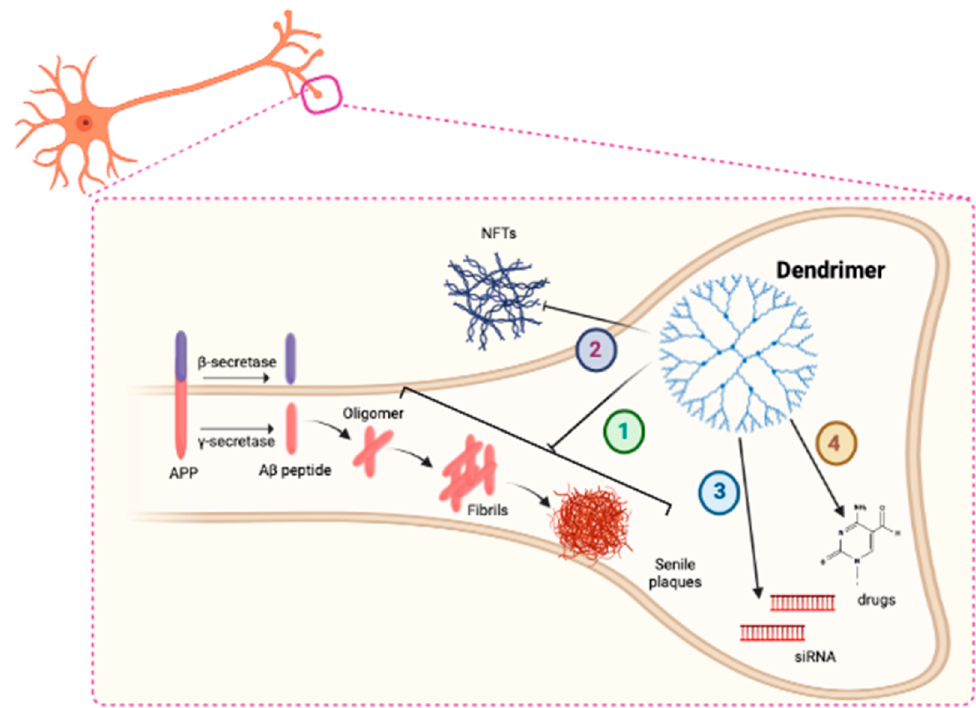
Figure 2. Schematic representation of the main mechanism of action of DDs in AD (1). DDs could interact with Tau and reduce its aggregation into neurofibrillary tangles (NFTs) (2). DDs could act as delivery systems for siRNA molecules (3) and drugs (4) in neurons.